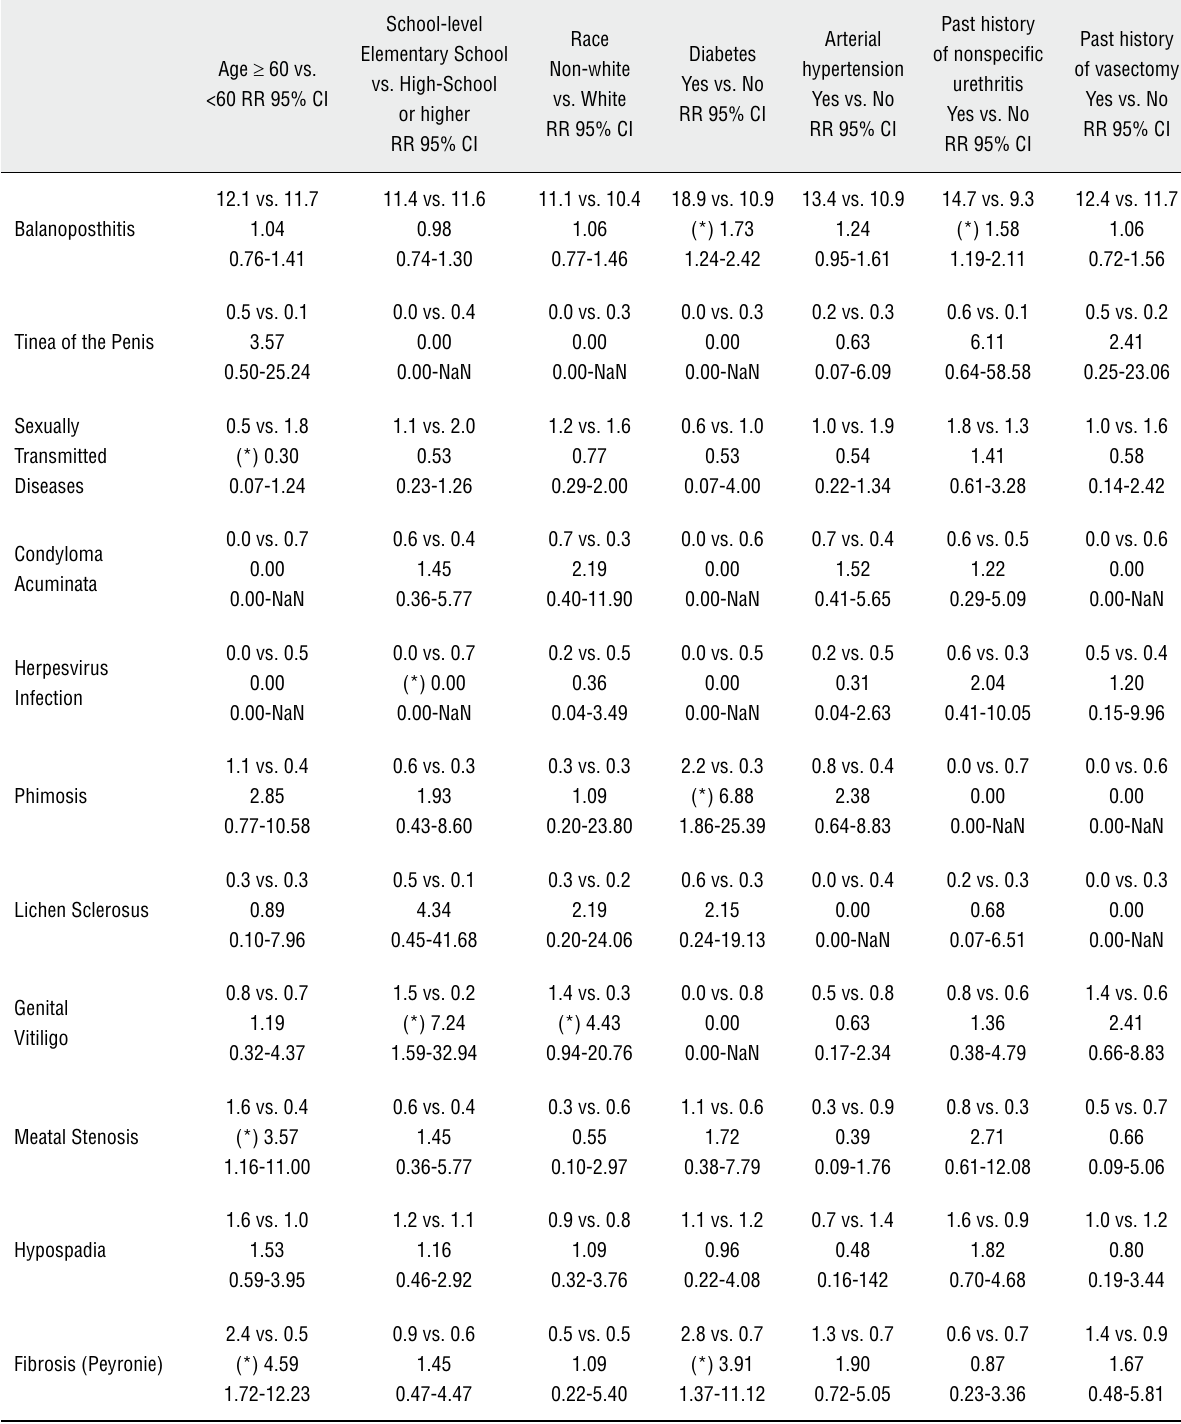
Table 2 - Prevalence of penile diseases, and relative risks (RR) and 95% confidence intervals (CI) of the lesions/anomalies ac- cording to age, school level, race, and history of diabetes mellitus, arterial hypertension, nonspecific urethritis, and vasectomy.